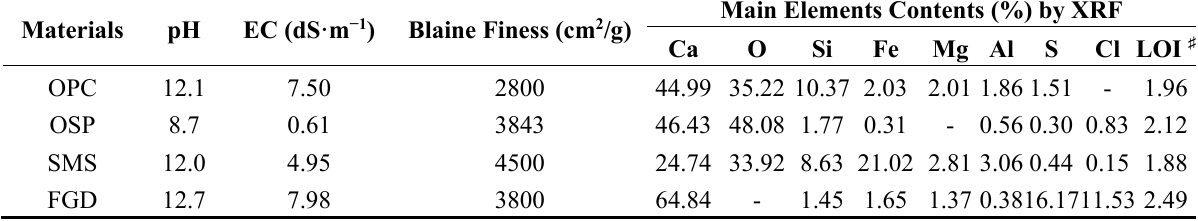
Table 2. Chemical properties and X-ray fluorescence (XRF) analysis results of admixtures. OPC: ordinary portland cement; OSP: oyster-shell powder; SMS: steelmaking slag dust; FGD: fuel-gas-desulfurized.